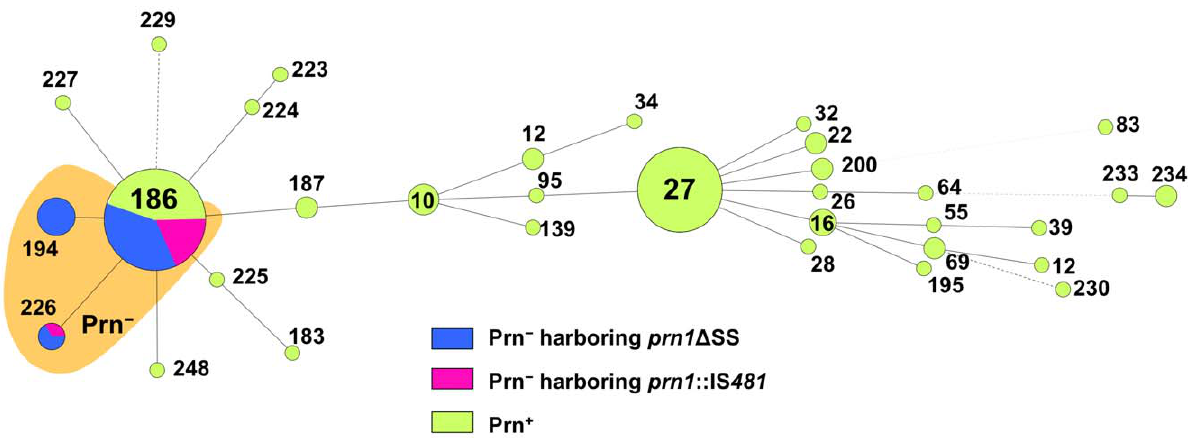
Figure 5. Minimum spanning tree of MLVA of Prn 2 and Prn + isolates. Total 121 B. pertussis isolates, collected during 1990–2009 in Japan, were subjected to MLVA: Prn 2 isolate harboring prn1 D SS, 24 isolates; Prn 2 isolate harboring prn1 ::IS 481 , 9 isolates; Prn + isolate, 88 isolates. Each circle in the tree represents a different MLVA type with the MLVA type number. The distance between neighboring genotypes is expressed as the similarity value. Prn 2 isolates belong to MLVA-186, -194, and -226.